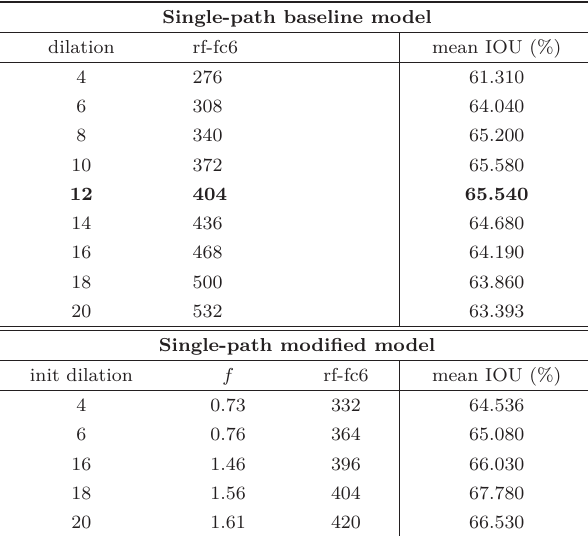
Table 3 Quantitative evaluation of baseline models and modified models using the PASCAL VOC 2012 validation